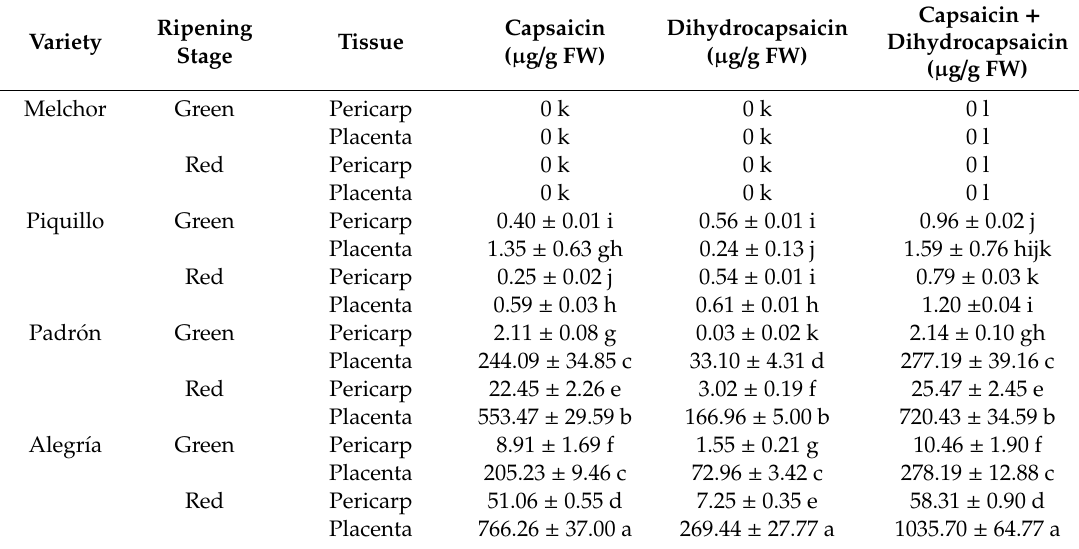
Table 2. Content of capsaicin and dihydrocapsaicin in pericarp and placenta from fruits of four pepper varieties at two ripening